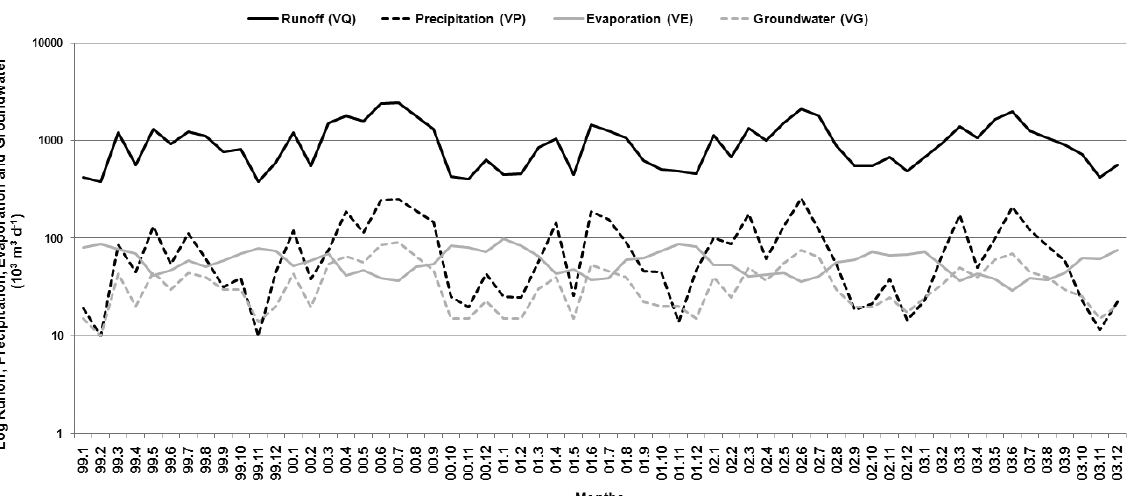
Fig. 2 – Monthly variation (averaged over 5 years, 1999-2003) of river flow discharge, evaporation and precipitation. Average historical rainfall and evaporation (1963-1990) at the BJE,